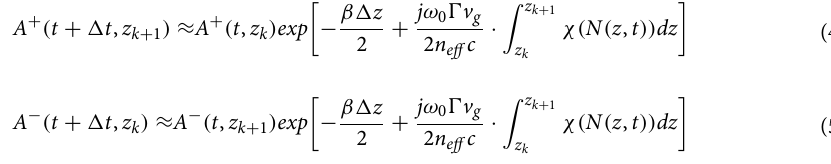
z z k 1 are given by 32 ≤ ≤ +